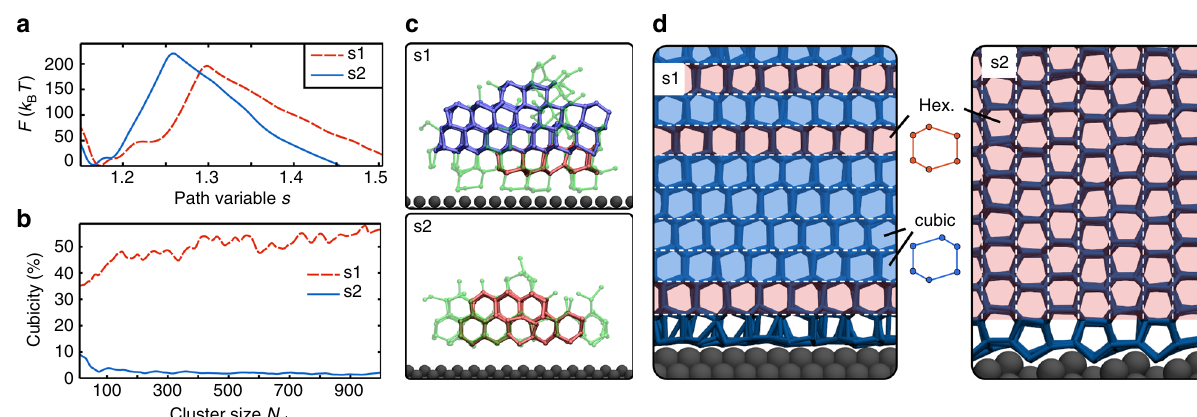
Fig. 3 Metadynamics results for heterogeneous ice nucleation at 235 K. a Free energy pro fi les as a function of the path variable s that describes the progression from liquid at s ≈ 1.1 toward the soft-wall at s = 1.5. b Cubicity as a function of the cluster size N cls . c Representative snapshots of critical clusters. Ice molecules and bonds are transparent green, while double diamond cages are blue, and hexagonal cages are red. d Subsection of the fully frozen cells, illustrating the substrate-induced polytype selection by avoiding the stacking